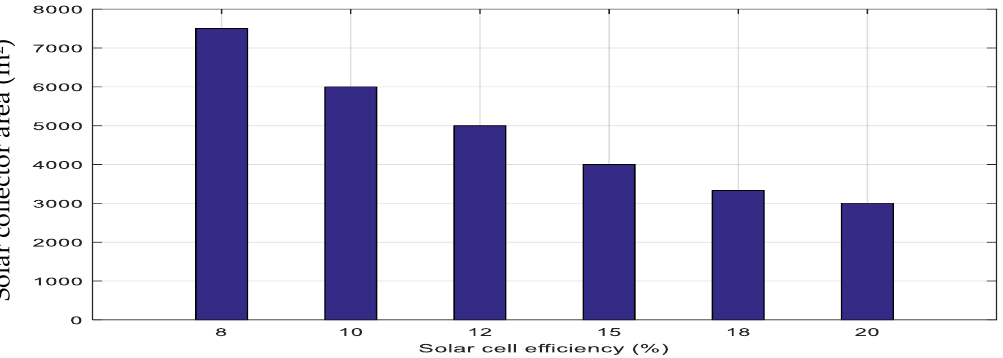
Figure 7. ( a ) Capacity factor. ( b ) Temperature sensitivities of various PV technologies in RETScreen.